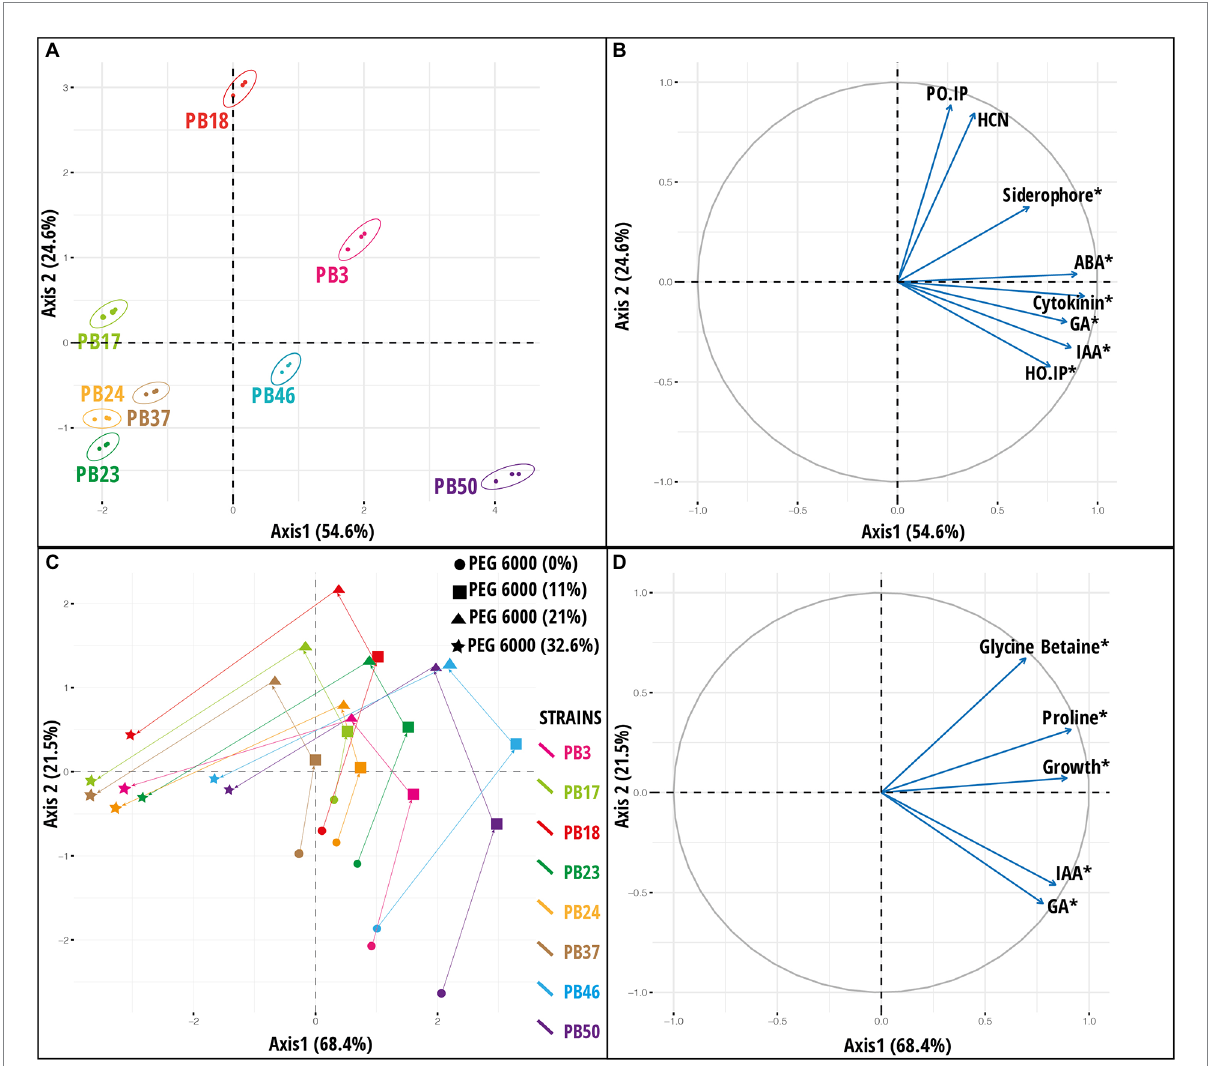
FIGURE 3 Results of principal component analysis (PCA) based on the plant growth-promoting (PGP) trait data of rice phyllosphere bacteria (number of replicates, n = 3). (A) Score plot and (B) loading plot of variables according to first two principal component axes. Bacterial strains are indicated by 95% confidence ellipses. The plots correspond to 79.2% of the total data variance and variance proportions are shown along each principal component axis. (C) Score plot and (D) loading plot of variables along first two principal component axes based on microbial dataset [indoleacetic acid (IAA), gibberellic acid (GA), proline, glycine betaine, and growth] of rice phyllosphere bacterial strains measured at different PEG 6000 concentrations (number of replicates, n = 3). The plots correspond to 89.9% of the total data variance, and variance proportions are shown along each principal component axis. Variables with asterisk in plot B and D are significant along the first principal component axis. Abbreviations used in plot (B) are, abscisic acid (ABA), hydrogen cyanide (HCN), Helminthosporium oryzae inhibition percentage (HO_IP), and Pyricularia oryzae inhibition percentage (PO_IP). The codes of the strains in plots (A,C) refer to the following strains: Bacillus endophyticus PB3, B . australimaris PB17, B . pumilus PB18, B . safensis PB23, Staphylococcus sciuri PB24, B . altitudinis PB37, B . altitudinis PB46, and B . megaterium